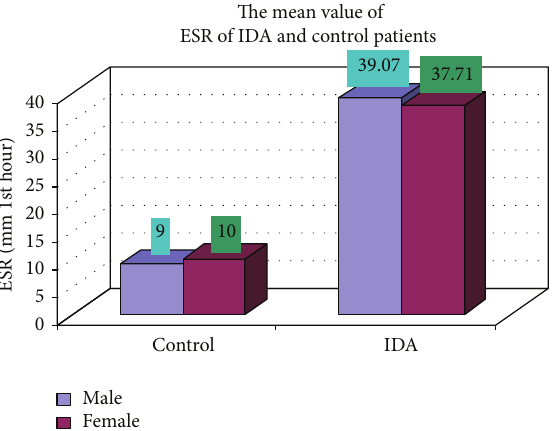
Figure 7: Showing PCV/hematocrit of control and iron deficiency anaemia.